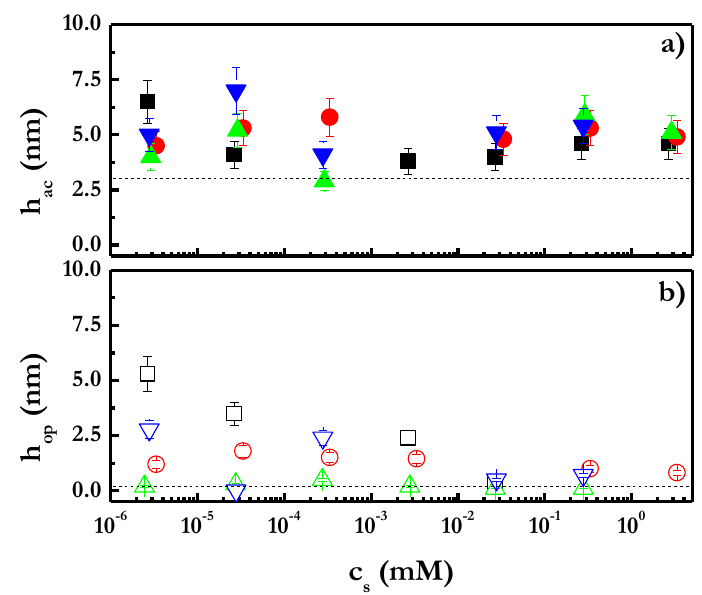
Figure 5. Dependence of h ac ( a ) and h op ( b ) on the surfactant concentration, c s , for the different DSPE-PEG + surfactant mixtures studied in this work: ( ■ , □ ) SLES, (●, ○ ) CB, ( ▲ , Δ) SLES+CB (molar ratio 3:2) and ( ▼ , ∇ ) SLMI. All the mixtures contain a fixed DSPE-PEG concentration of 5 g/L, and their ionic strength and pH were fixed a 40 mM (KCl) and 5.6, respectively. The dashed lines correspond to the values of acoustical and optical thicknesses for the adsorption of a DSPE-PEG layer from a solution with concentration 5 g/L and the same ionic strength and pH than the mixtures.